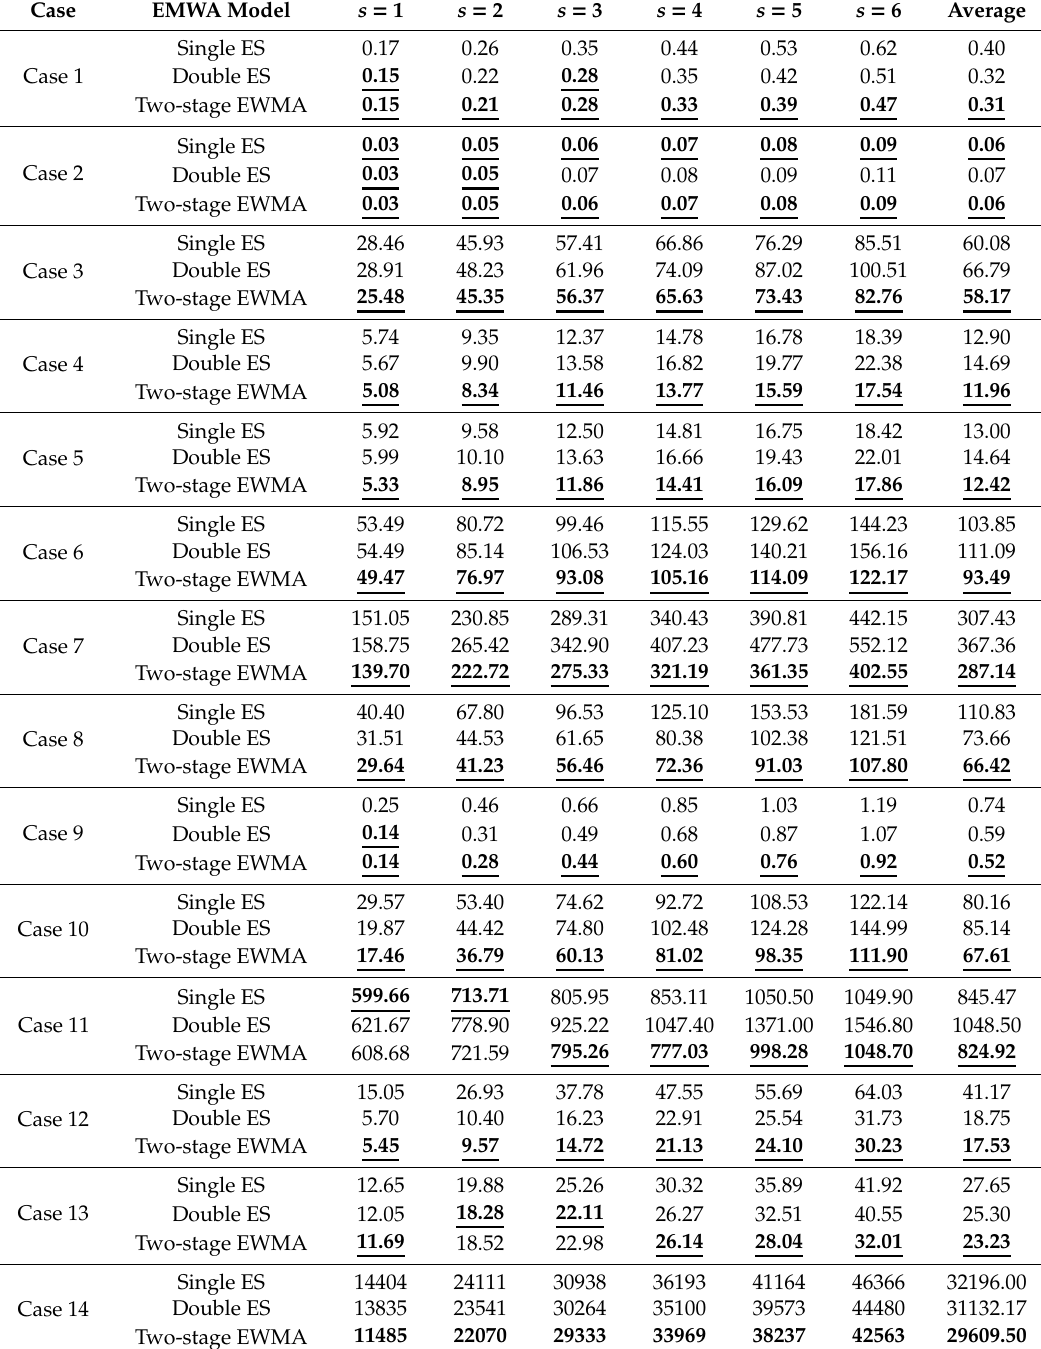
Table 2. RMSE values of EWMA models in 14 real cases varying forecasting